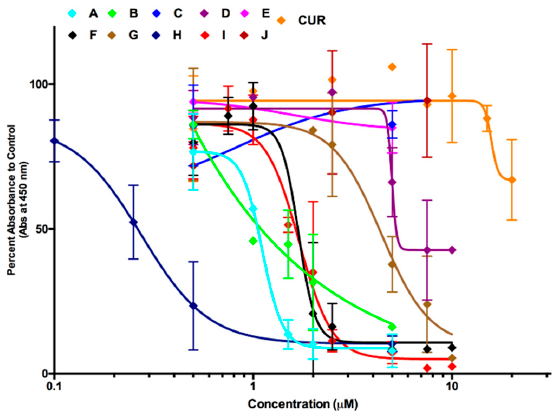
Figure 2. Effect of various curcumin analogs on cell viability of A375 melanoma cells. A375 melanoma cells were treated with natural curcumin (CUR) and curcumin analogs (A-J) for 48 h. The WST-1 assay was performed as described in the materials and methods section. Values are expressed as a mean ± SD from at least three independent experiments. The x -axis represents concentration ( μ M) and the y -axis represents absorbance (% of control). Graph obtained using the log (inhibitor) vs. response—variable slope (four parameters) curve on GraphPrism6.